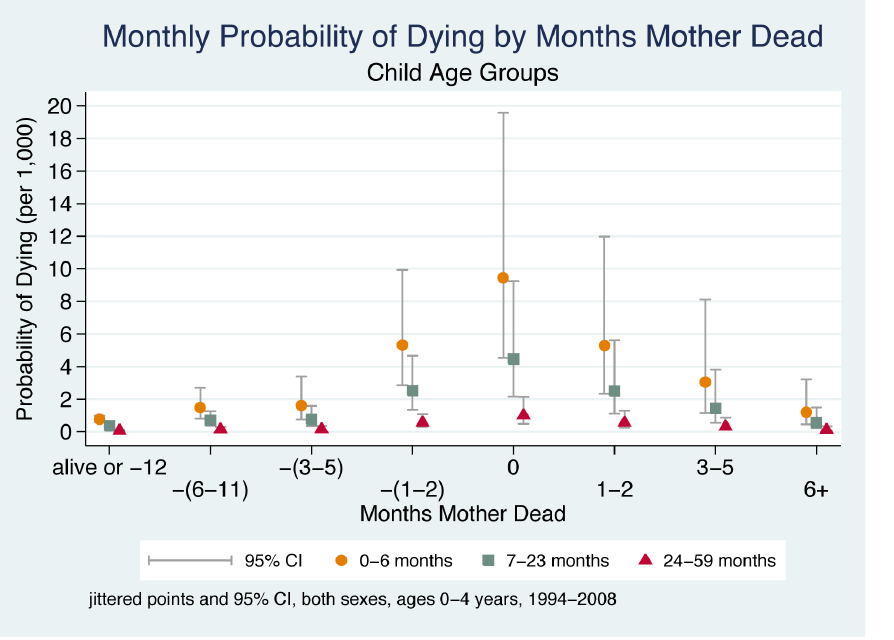
Figure 3. Monthly probability of child death in Agincourt sub-district, South Africa (1994–2008) by time before/after mother’s death and child age. On the x- axis, the mother’s death occurs in month 0, and time periods before and after her death are shown to the left and right of month 0, respectively. Children whose mother did not die during the study are included in the time period ‘‘alive or 2 12’’. Jittered (offset) points to reduce overplotting.